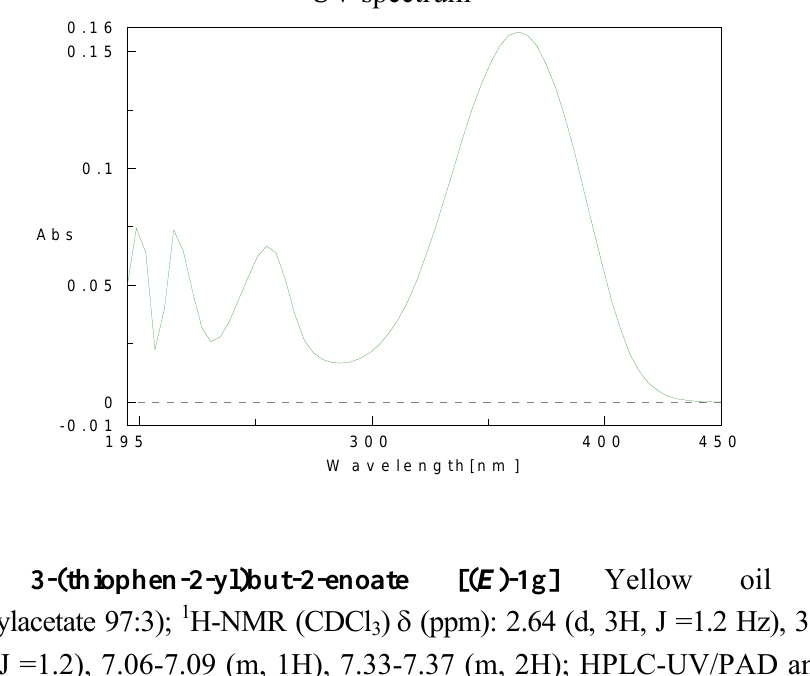
3-(thiophen-2-yl)but-2-enoate [( E )-1g] Yellow oil R